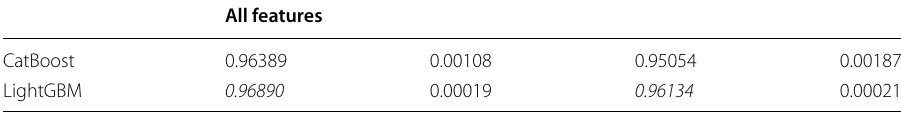
Best metrics are highlighted in italics; SD AUC is the standard deviation of AUC and SD F1 is the standard deviation of the F1-score